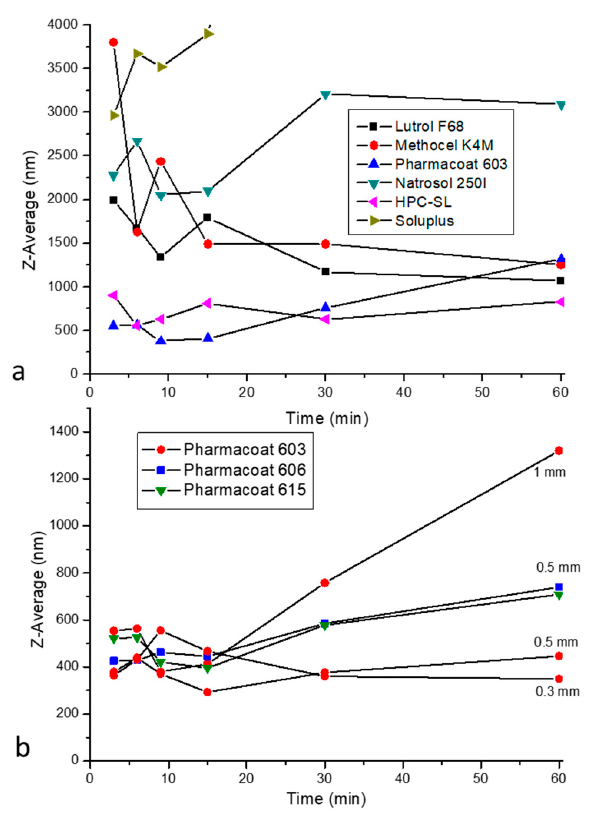
Figure 1. Time evolution of Z-average particle size of IBU: ( a ) in presence of different stabilizers, and ( b ) the effect of Pharmacoat solution viscosity (represented by different Pharmacoat grades), and bead diameter in presence of Pharmacoat 603.